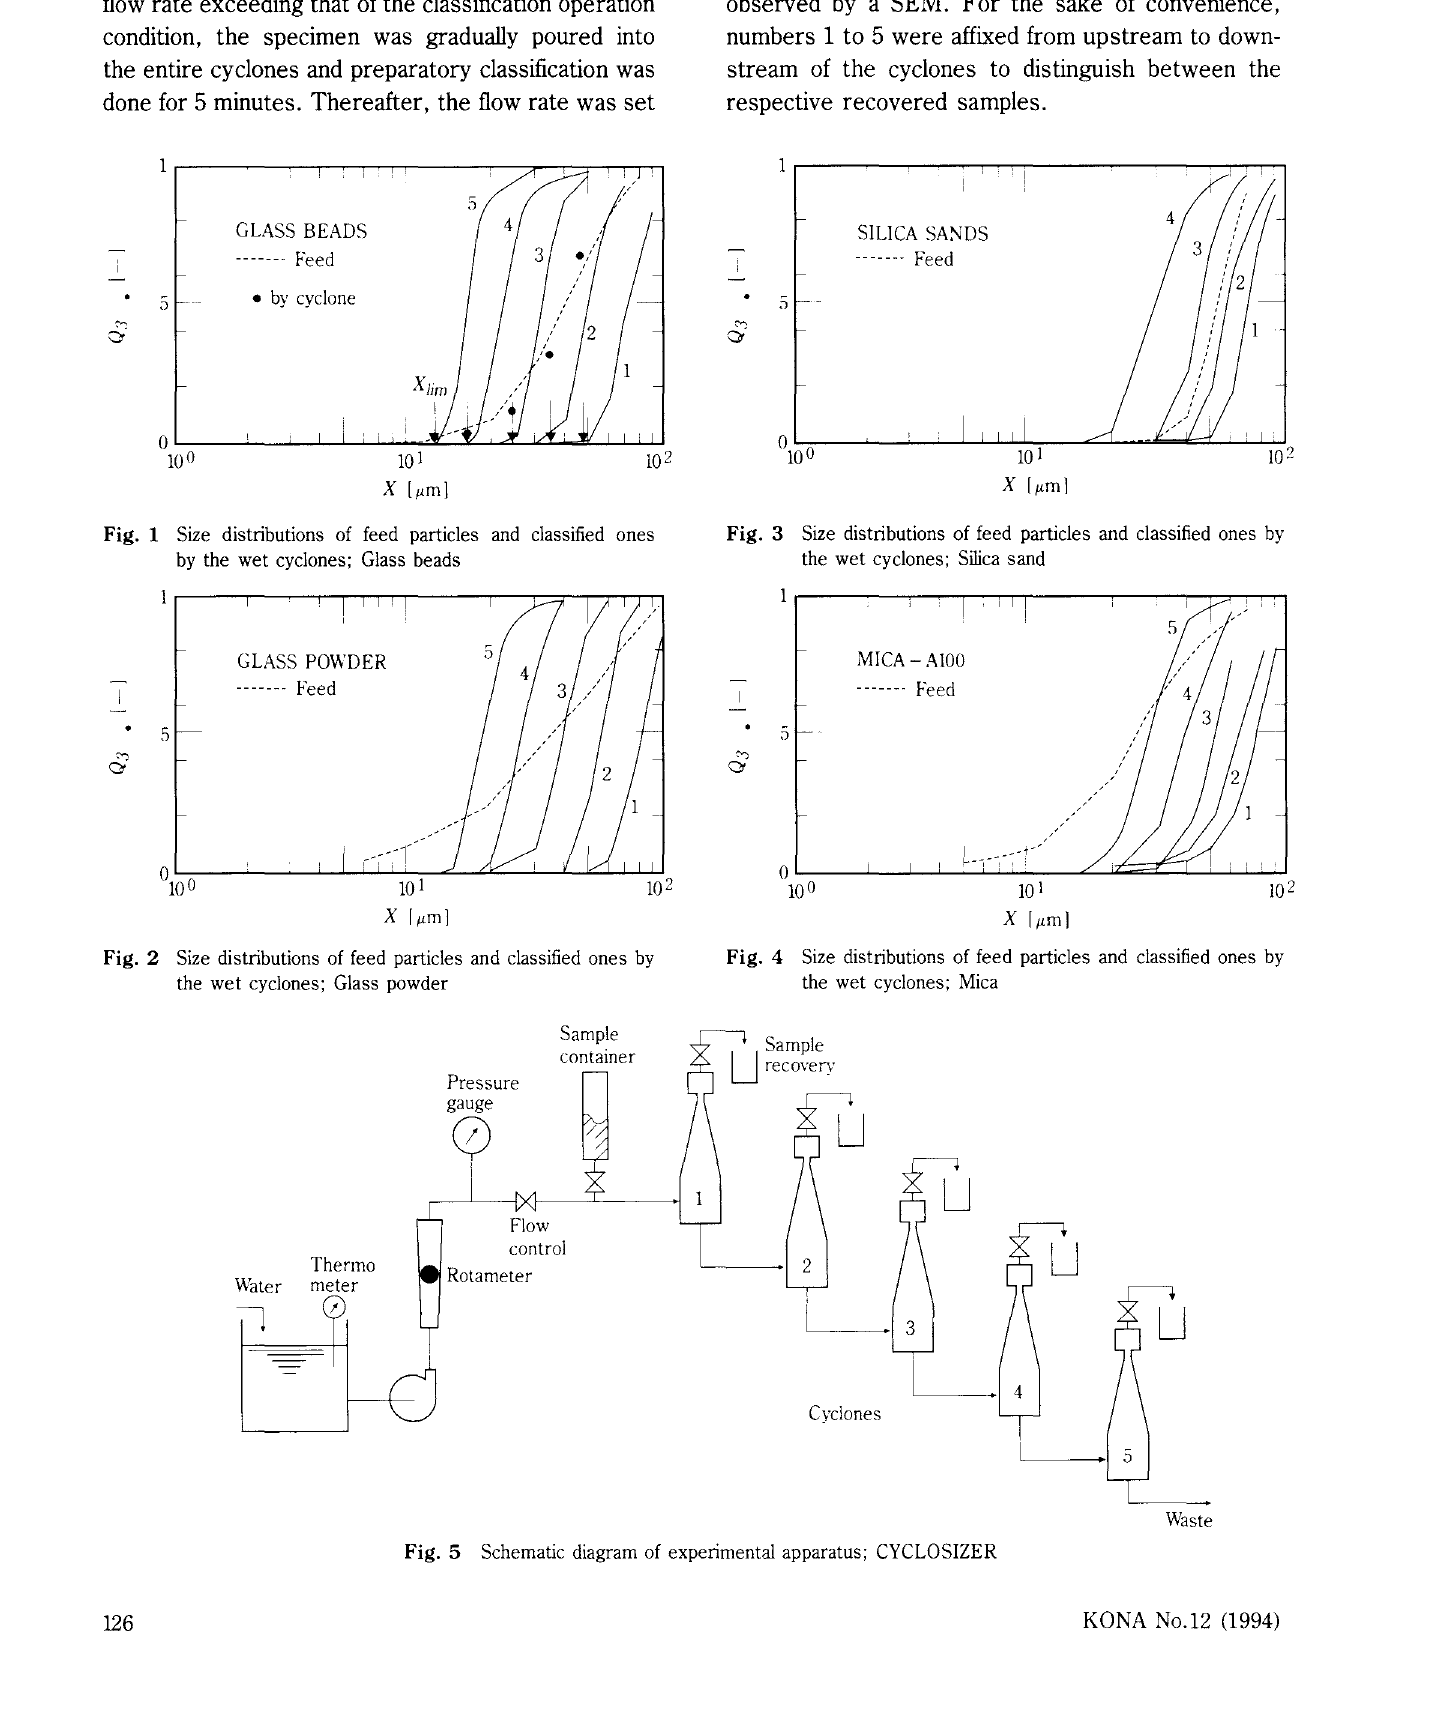
Fig. 5 Schematic diagram of experimental apparatus;